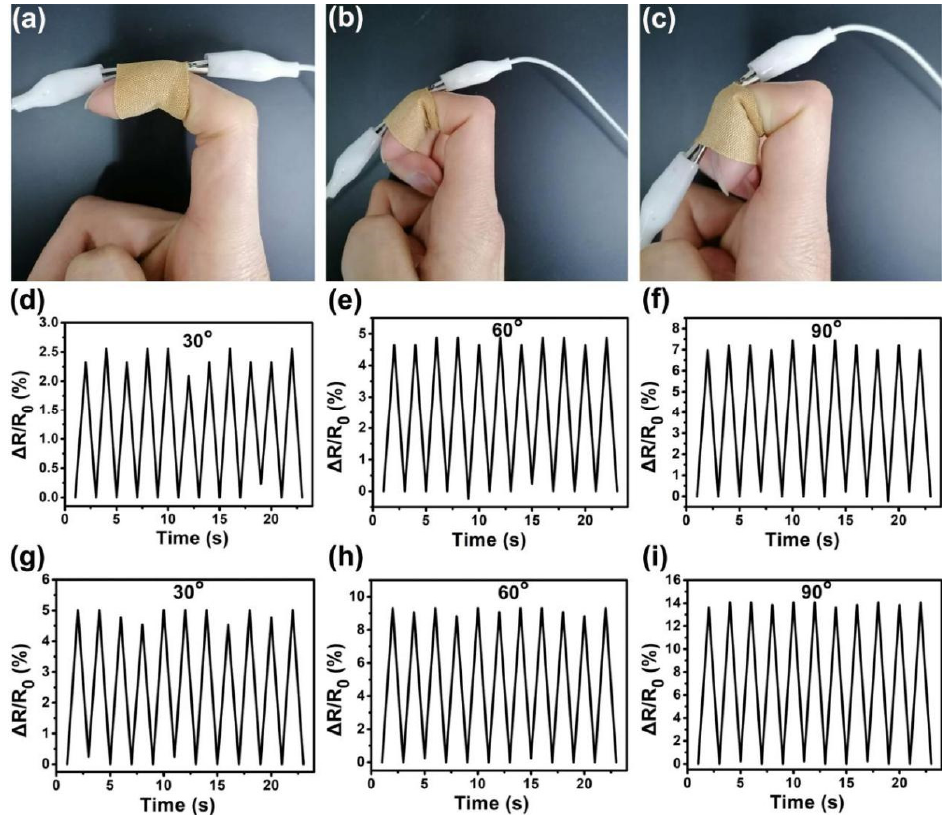
Figure 5. Response of pressure sensor to real-time human motions. ( a – c ) Pressure sensor fixed on the finger with a band-aid to monitor the bending motion of the joint at different angles. ( d – f ) The resistance change rate of a single planar pressure sensor with no surface microstructure when the finger performs 30, 60, and 90 degree cyclic bending motions. ( g – i ) The resistance change rate of the interlocking micro-dome pressure sensor when the finger performs 30, 60, and 90 degree cyclic bending motions.